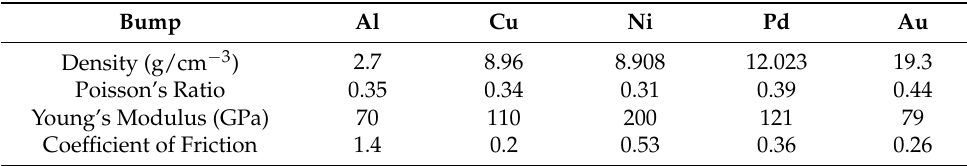
Table 1. Material property parameters in finite element analysis (FEA).